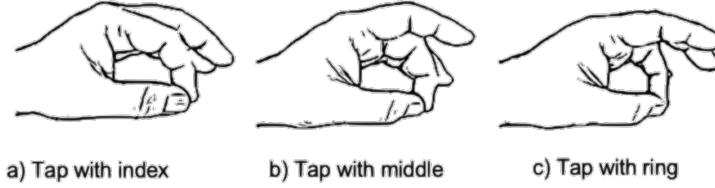
Figure 2. Three of the subtle gestures selected for data labeling. They require users to tap their thumb once with either the index, middle or ring finger. The three additional gestures are similar but require a double tap from the